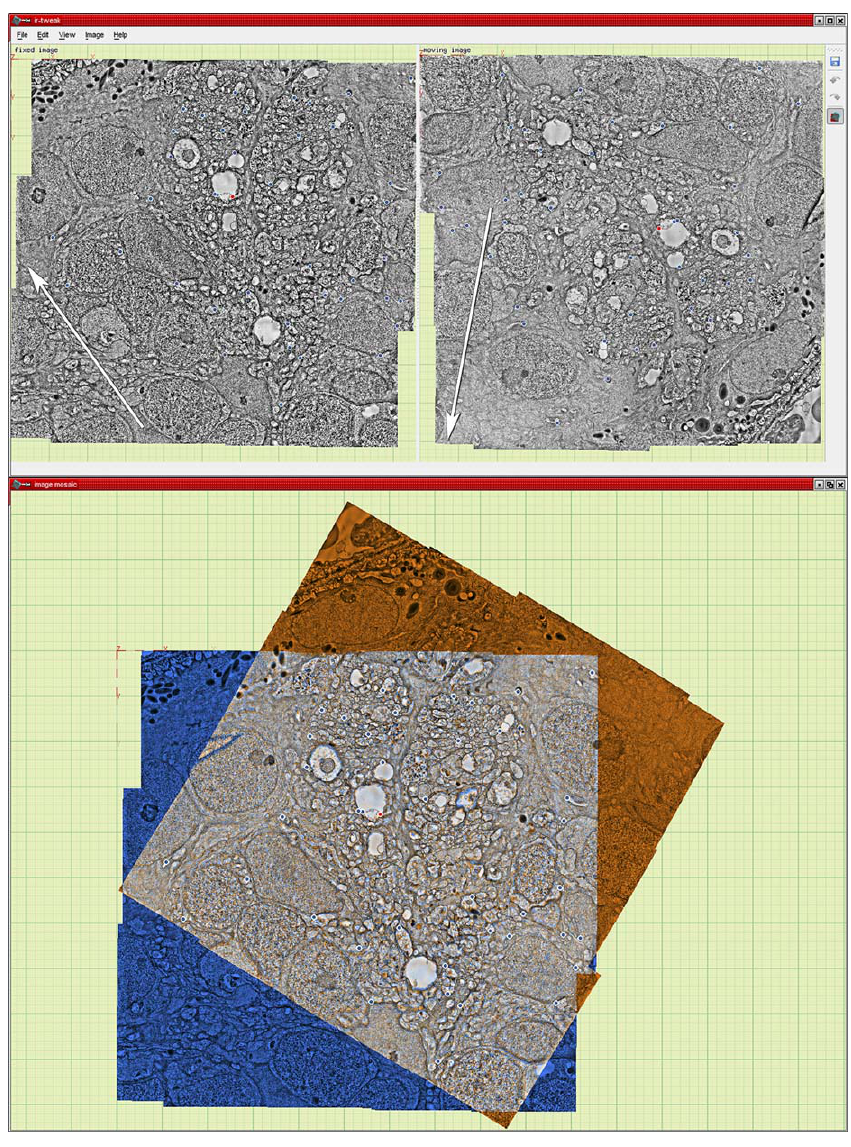
Figure 8. Registering ssTEM Image Tiles with ir-tweak The entire image represents two windows of the ir-tweak interface. The top window shows two serial sections from a manual film capture with tiles in different orientations (arrows), the left being the fixed and the right the moving or warped image. Successive control points (dots) entered on the fixed image by the user are predictively placed on the moving image based on the model calculated from all previous points, with a thin-plate spline strategy for accommodating local warps. The bottom panel shows the superimposed fixed (blue) and warped (orange) in